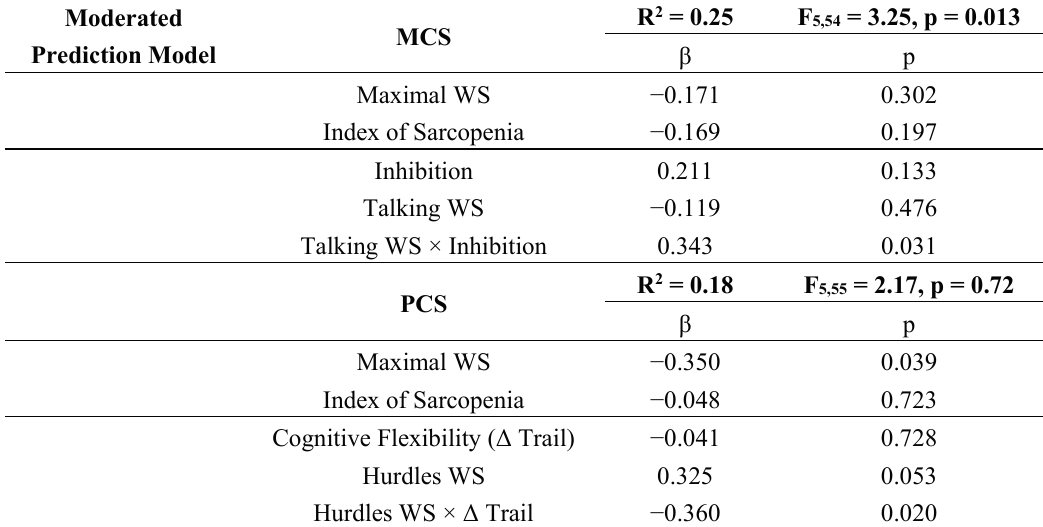
Table 4. Hierarchical regression models testing moderated prediction of mental (MCS) and physical (PCS) HRQoL. Total R 2 explained, ANOVA results, and standardized β coefficients with level of significance are also reported. (WS = walking speed; Δ Trail = cognitive